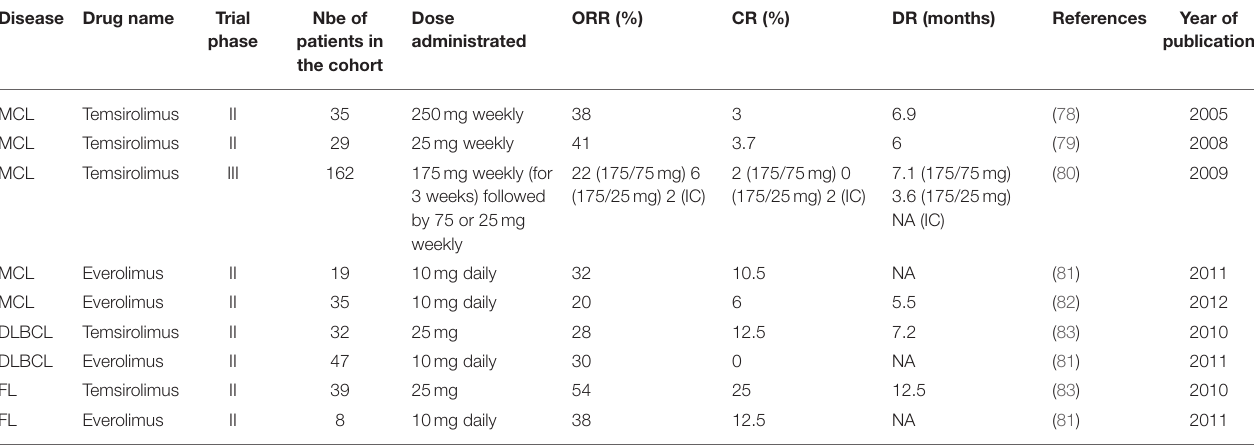
TABLE 1 | Summary results of phase II and III studies evaluating the effect of rapalogs as a single agent in the treatment of refractory/relapsed NH B-cell lymphomas. Disease Drug